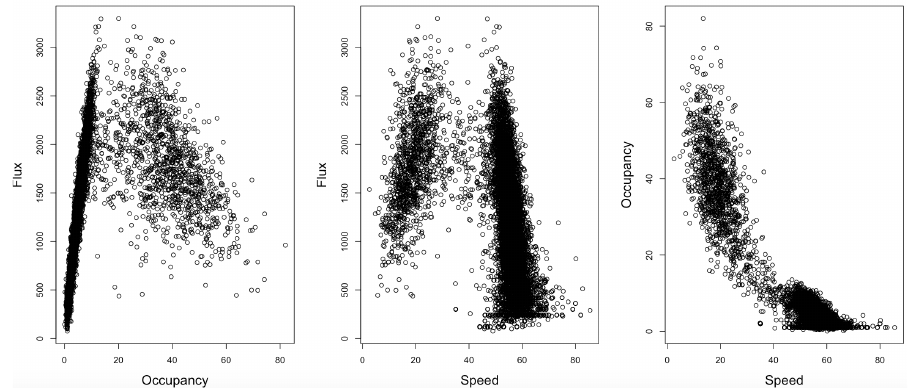
Figure A1. Pairwise scatterplots of Rome Data in the road Viale del Muro Torto: flux vs. occupancy ( left ); flux vs. speed ( middle ); and occupancy vs. speed ( right